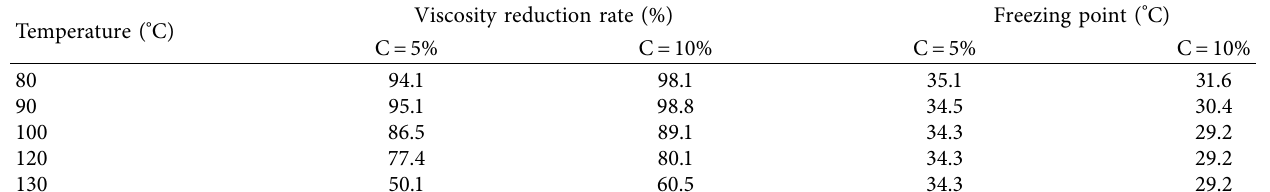
Table 6: Influence of different temperatures on viscosity reduction rate and freezing point of